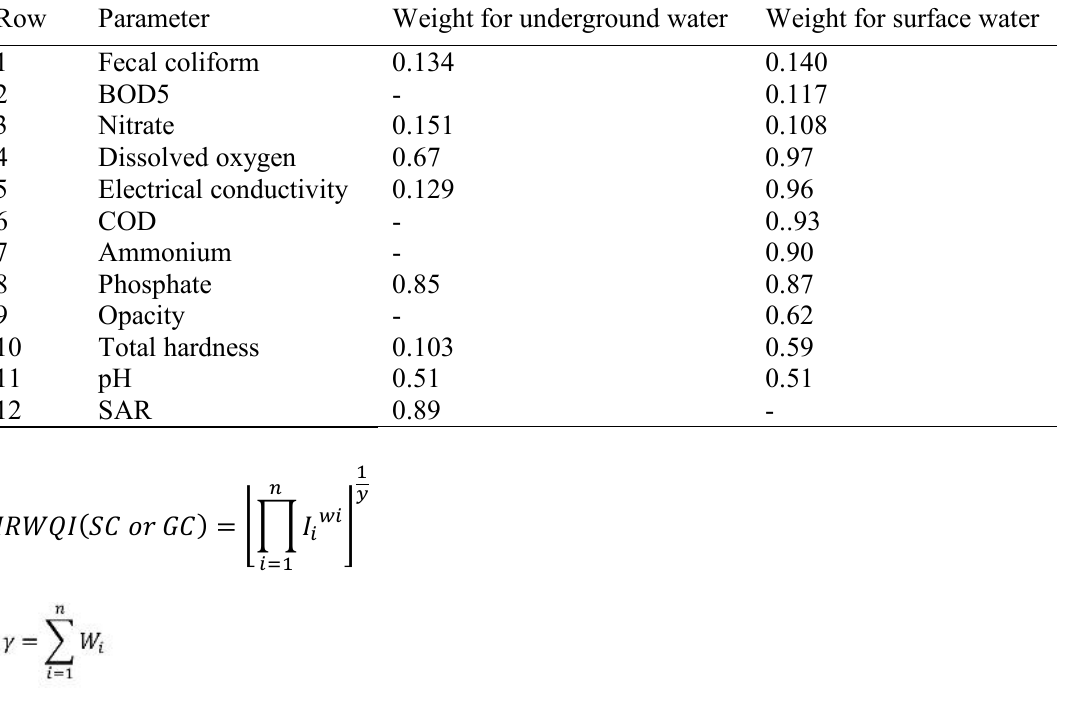
Table 4. Measured parameters of common contamination of the index and their weights in surface water (IRWQI SC and groundwater (IRWQI